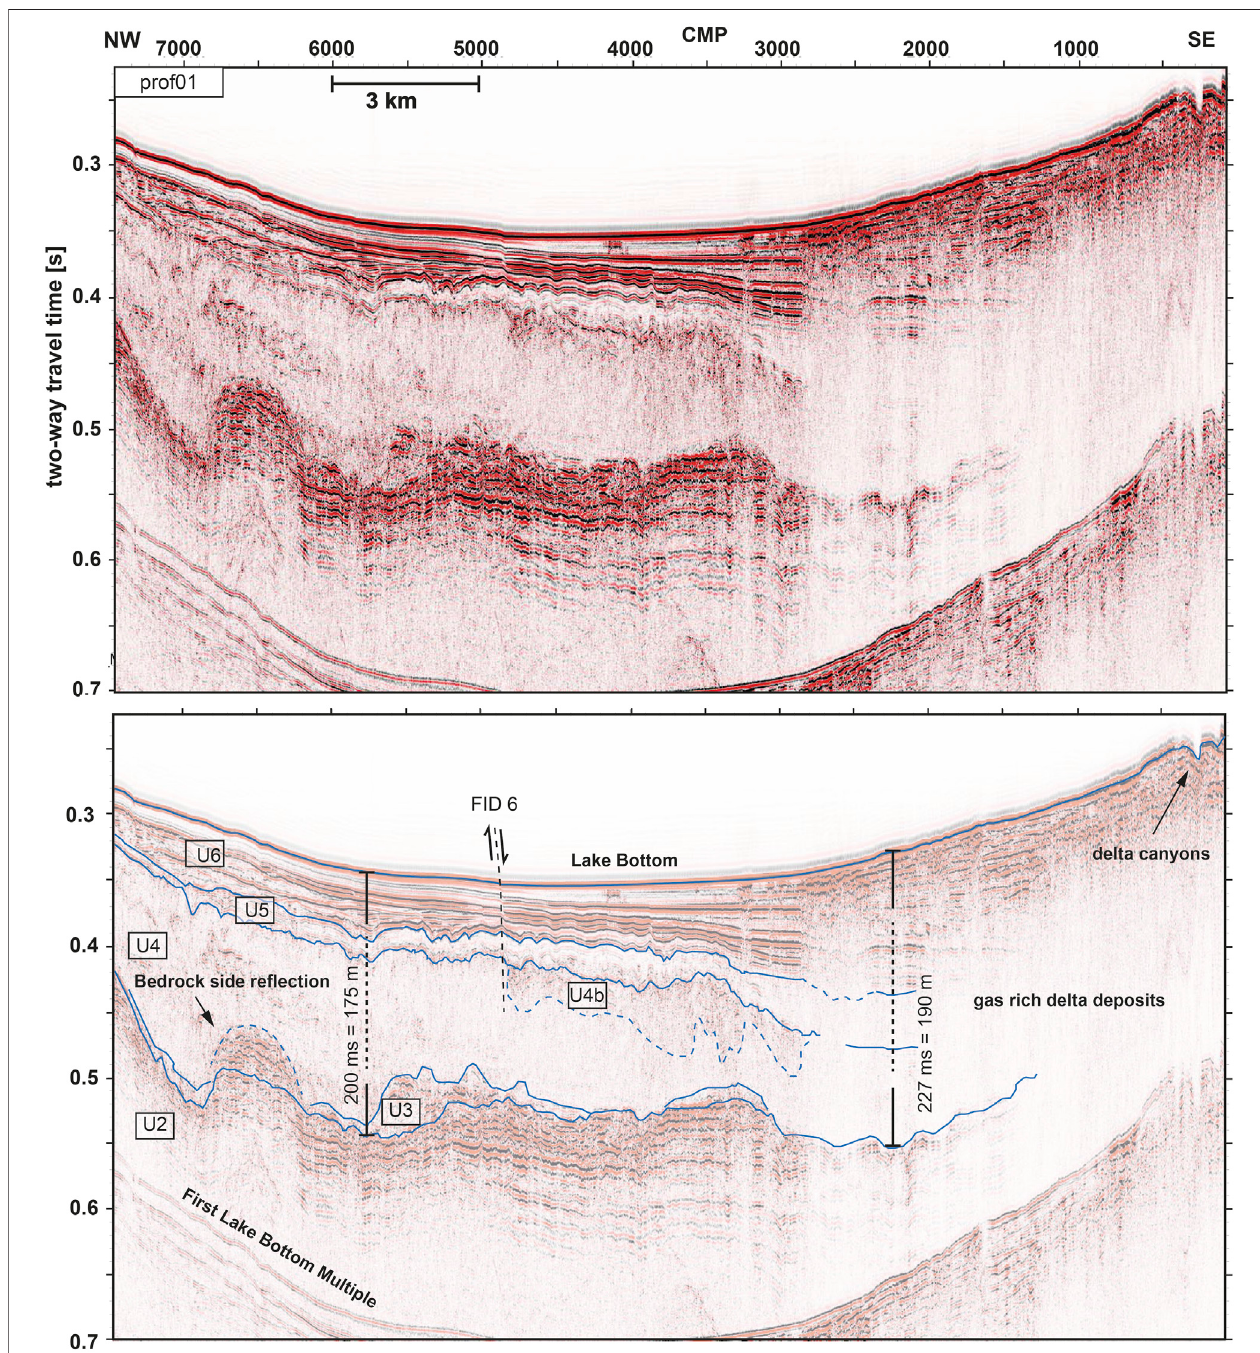
FIGURE 4 | top: Multi-channel re fl ection seismic data of line prof01 along the OB (location in Figure 3 ). Bottom: Interpretation of seismic section with fi ve stratigraphicunitsU2-U6(compare Table1 ).Furthersubdivisionofthemainunits(e.g.,U4b)markprominentdisturbances ofthemainunits.Offsetre fl ectionsinunitU6 at CMP5000culminate at thelakebottom and shownormal faulting.Gas-richdeltadeposits prohibitsignal penetration intheSE.190 mand 175 msedimentcoverage can beobserved inthedelta distal areaand thecentral basin,respectively, taking intervalvelocitiesintoaccount( SupplementaryTableS3 ).Note thatbeddingof Molasse bedrock U2 is clearly visible, and allows investigating bedrock-rooting active fault structures (FID 6 — Kippenhorn Fault).